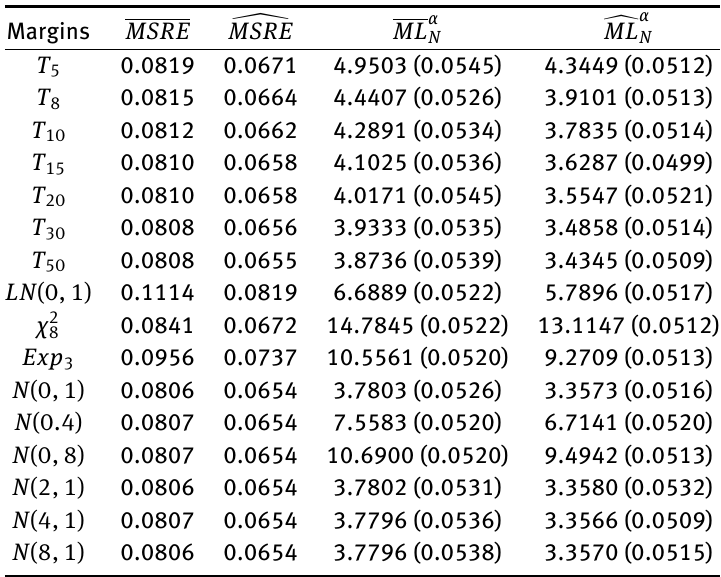
as a function of the marginal distributions. Numbers in parenthesis are the proportion of Table 1: Evolution of MSRE and ML α N observed values out of prediction